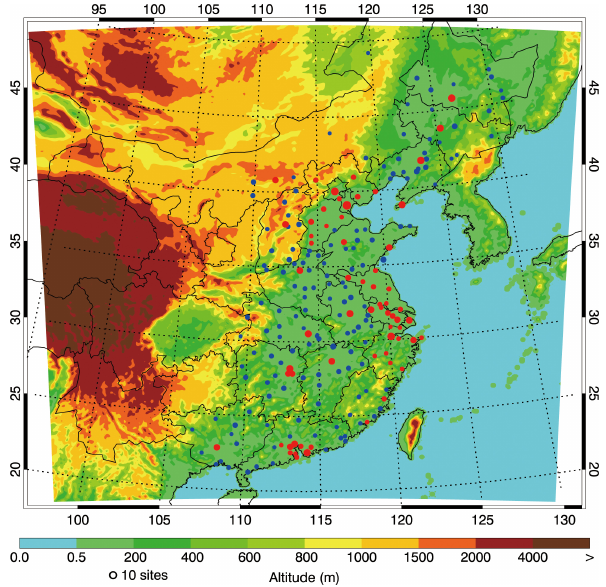
Figure 1. WRF-CHEM simulation domain with topography. The filled circles represent centers of cities with ambient monitoring sites and the size of circles denotes the number of ambient moni- toring sites of cities. The red and blue filled circles show the cities with air pollutant observations since 2013 and 2015,